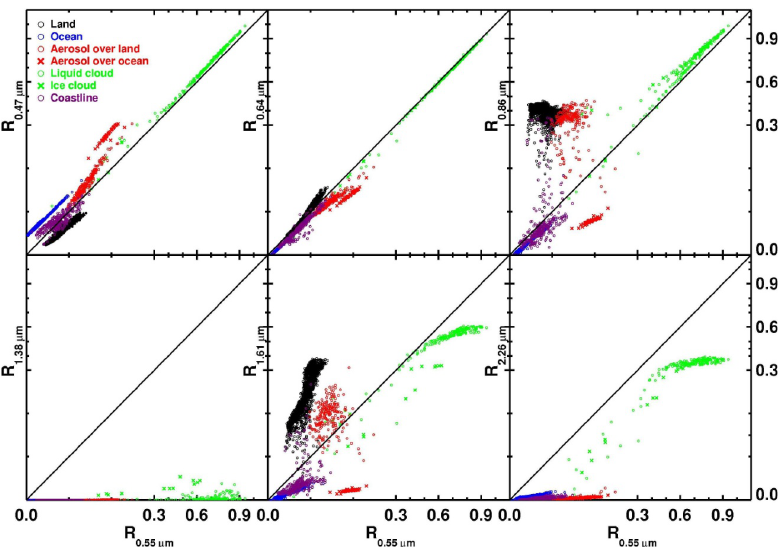
Figure 5a Fig. 5a. Plot of reflectance at the visible and near-IR bands against reflectance at the green band at 19:00UTC, 10 June 2008. The Spectral signatures are shown for land, ocean, aerosol (over land and ocean), cloud (water and ice), and coastline. Note that the reflectance interval of 0.0 to 0.3 is enlarged to show more details of signatures from land, ocean, aerosol, and